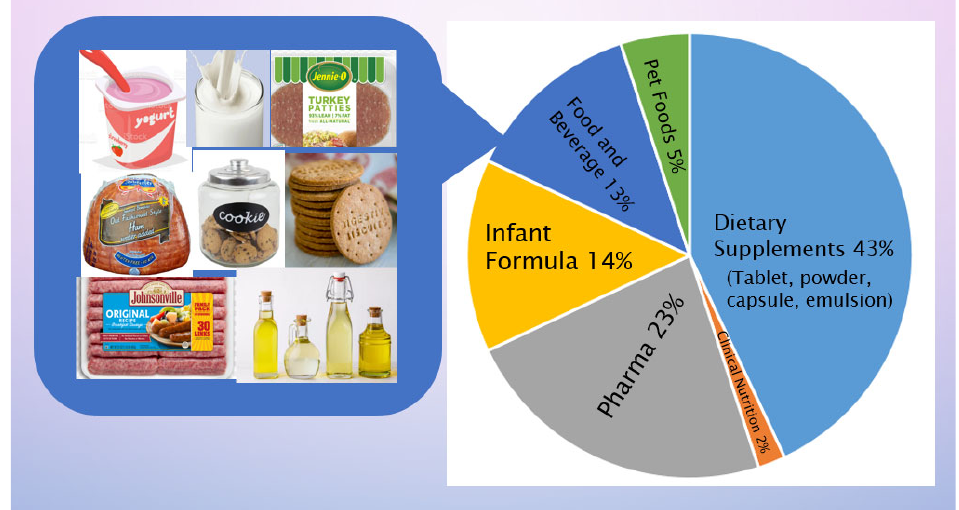
Figure 1. Application category and proportion of n ‐ 3 PUFA production (EPA/DHA) products in the global market (Modified from figure in [162]).